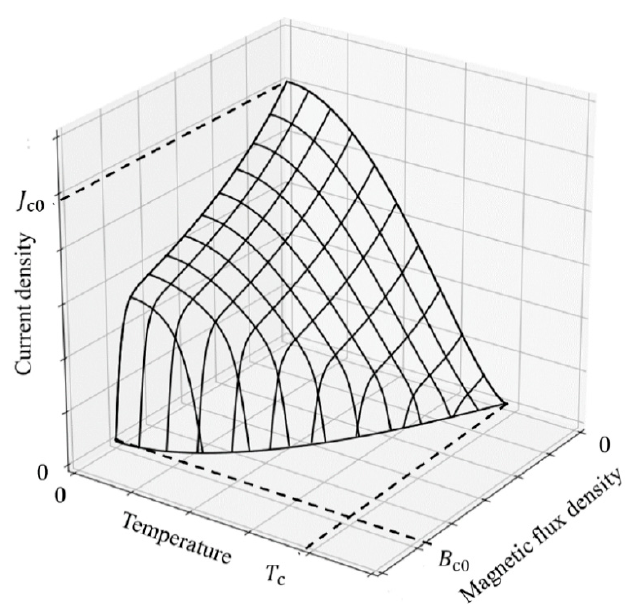
Figure 3. An example of the surface of critical parameters in a superconducting material.